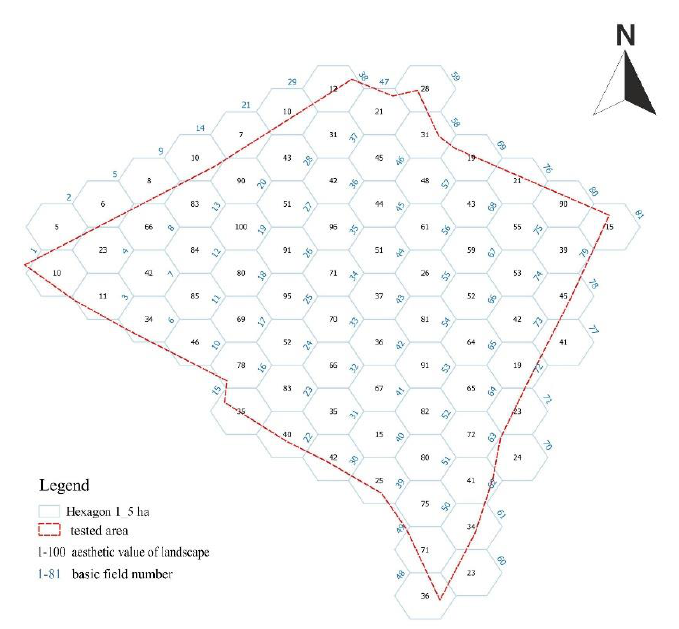
Figure 10. The stage of revealing the relationships of the minimum landscape aesthetic value decrease. Source: Own analysis.